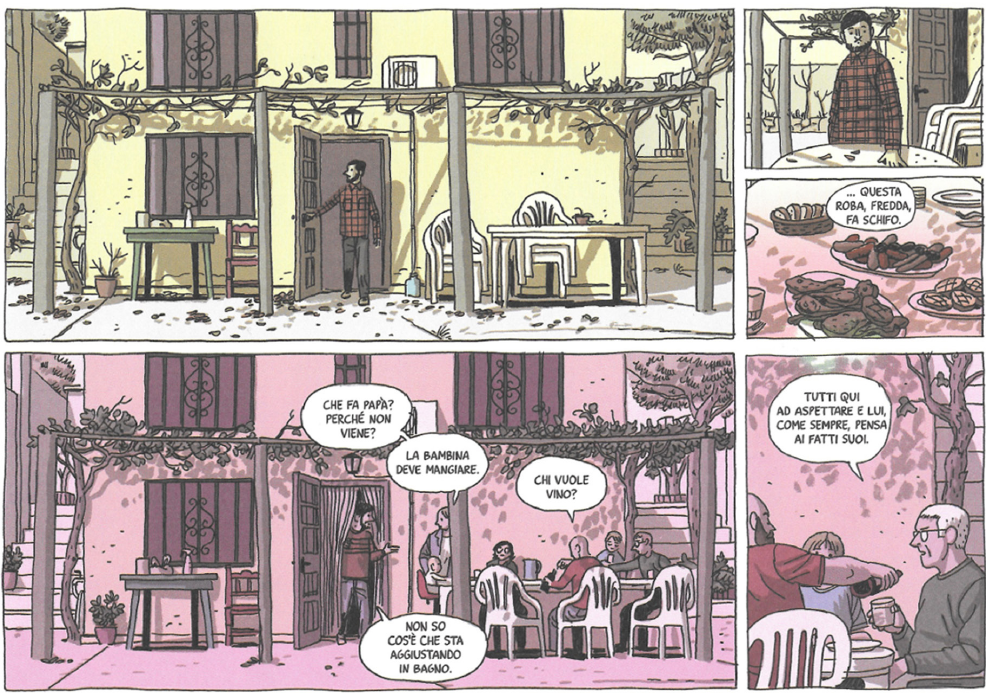
Fig. 12 One of the flashbacks of the story described with evident color change on the page (Roca, 2016, p.